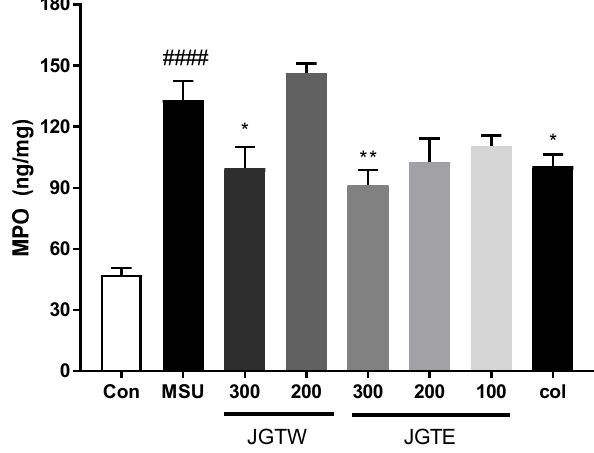
Figure 6. E ff ects of JGTW and JGTE on myeloperoxidase (MPO) activity in MSU crystal-injected paw tissue. Con, control mice; MSU, MSU crystal-injected mice; JGTW, MSU-injected mice treated with JGTW; JGTE, MSU-injected mice treated with JGTE; Col, MSU-injected mice treated with 1 mg / kg of colchicine. Data are presented as mean ± SEM ( n = 5). #### p < 0.0001 vs. Control group and * p < 0.05, ** p < 0.01 vs. MSU group.